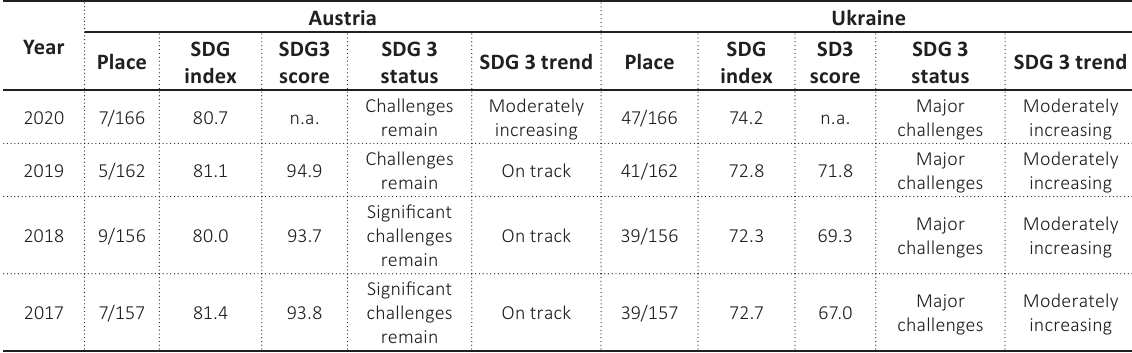
Table 3. The assessment of progress in achieving targets of SDGs 3 in Ukraine and Austria according